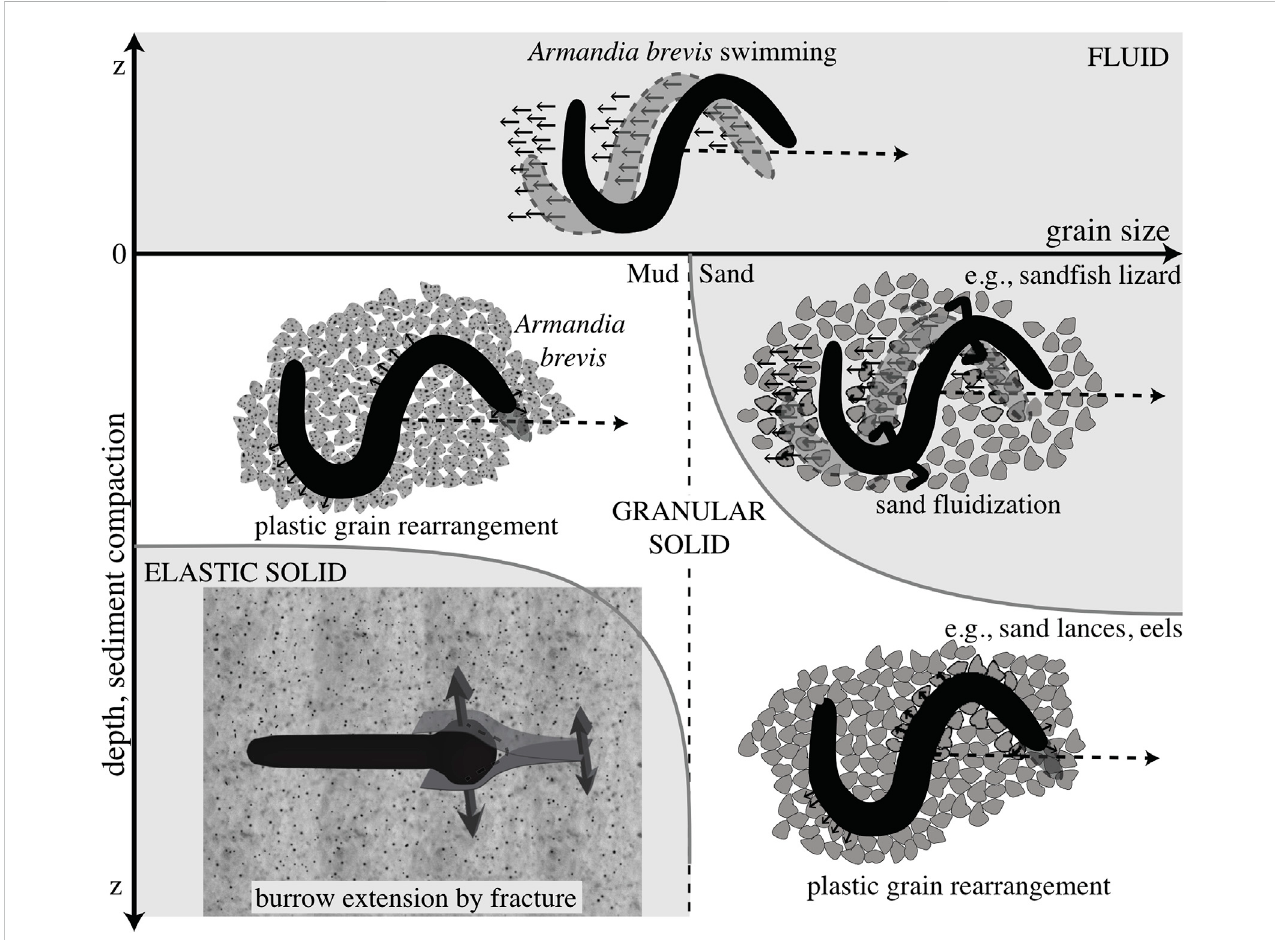
FIGURE 4 Schematic diagram of different mechanisms of burrowing in idealized muds (left) and sands (right). Dotted line indicates a later time, and the differing mechanics of the media are indicated. Swimming through a fl uid is distinguished from plastic grain rearrangement of granular solids in that the body slips backwards in fl uids butfollowsapath without slippinginsolids.These mechanismsaredistinguishedfrom burrowingby fracture inelastic muds. Reproduced from Dorgan et al. (2013) with